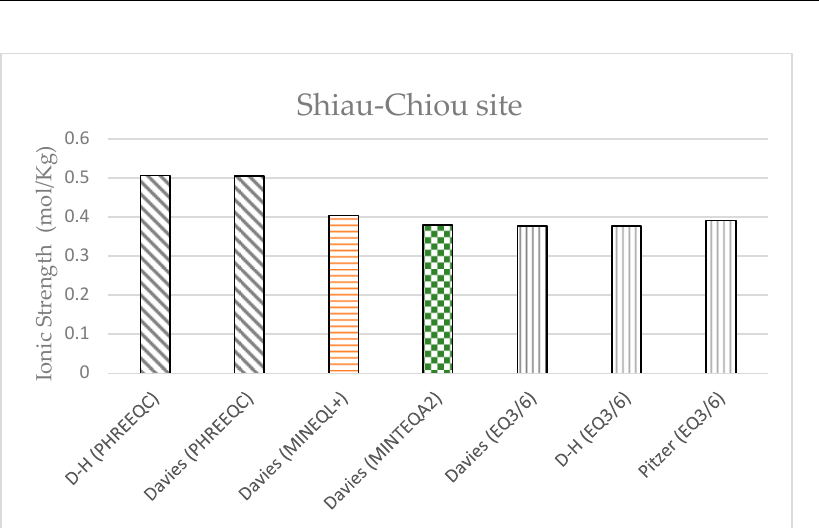
Figure 17. Calculated ionic strengths for the four models with different activity coefficient equations at the Shiau-Chiou site.